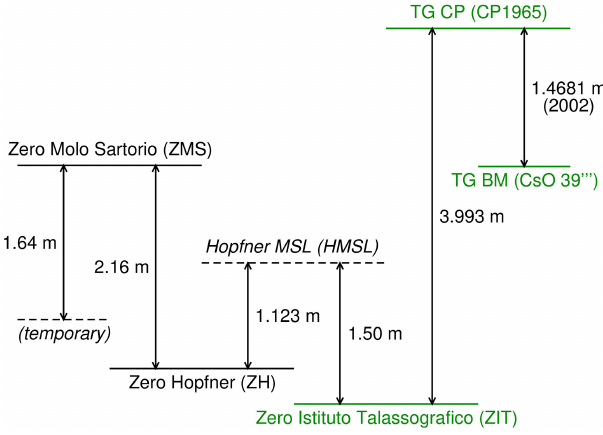
Figure 5. The relationships between the tide-gauge zeros and their connections to the TG CP and benchmark (TG